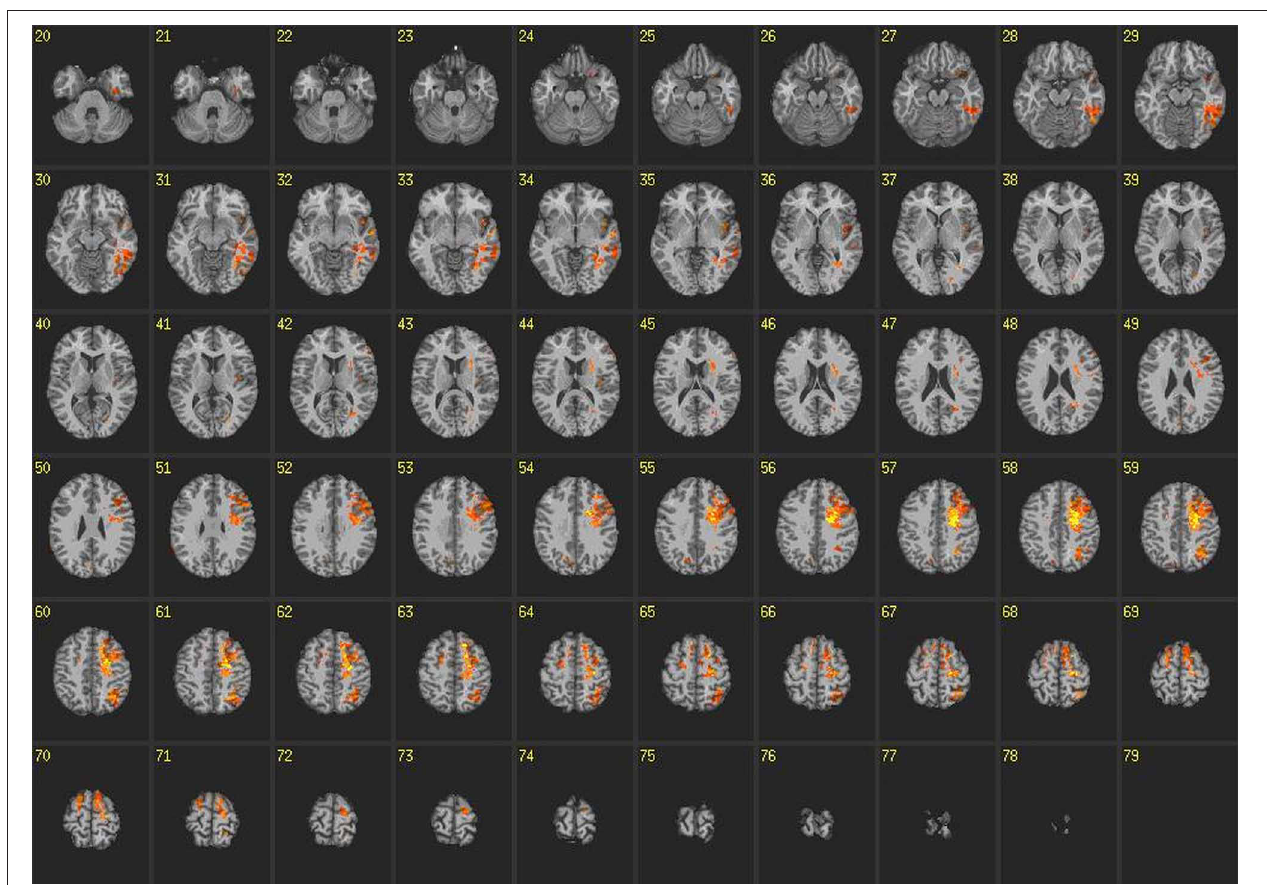
FIGURE 5 | Voxel-based lesion-symptom maps: incongruent blocks. VLSM maps for reaction times on incongruent blocks of the IAT. Colored voxels are significant at p < 0 . 05 correcting for multiple comparisons. Brighter colors indicate stronger statistical